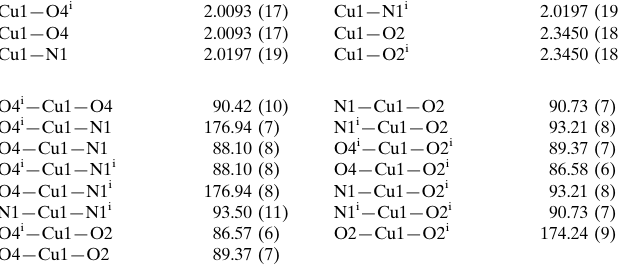
Selected geometric parameters (A˚ , (cid:2)